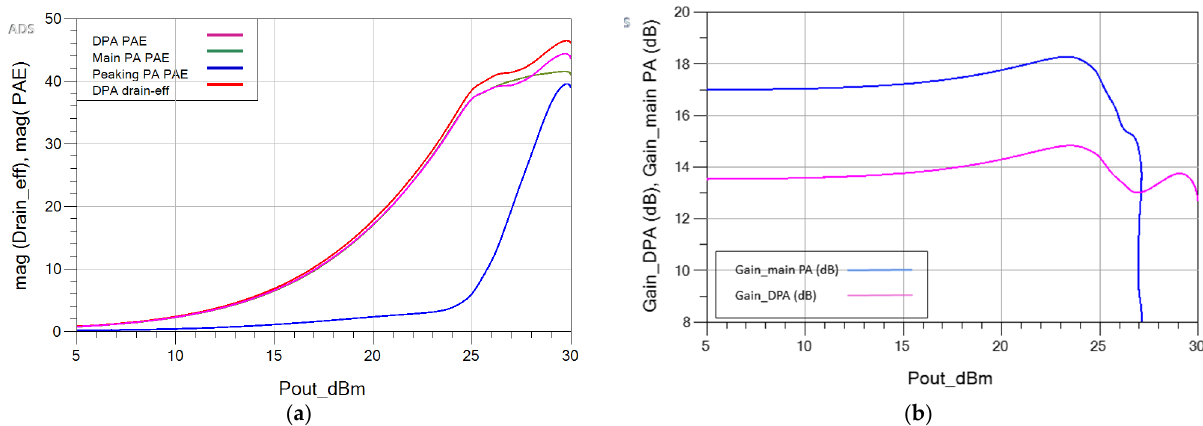
Figure 7. Simulated ( a ) magnitude of PAE and drain efficiency at the center frequency, ( b ) power gain of the main PA in comparison with the DPA gain in terms P out